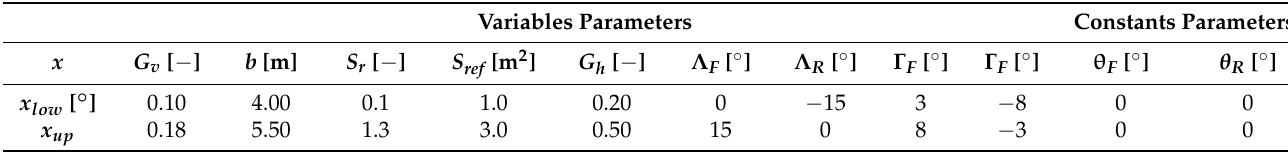
Table 2. Example of parameters settings in